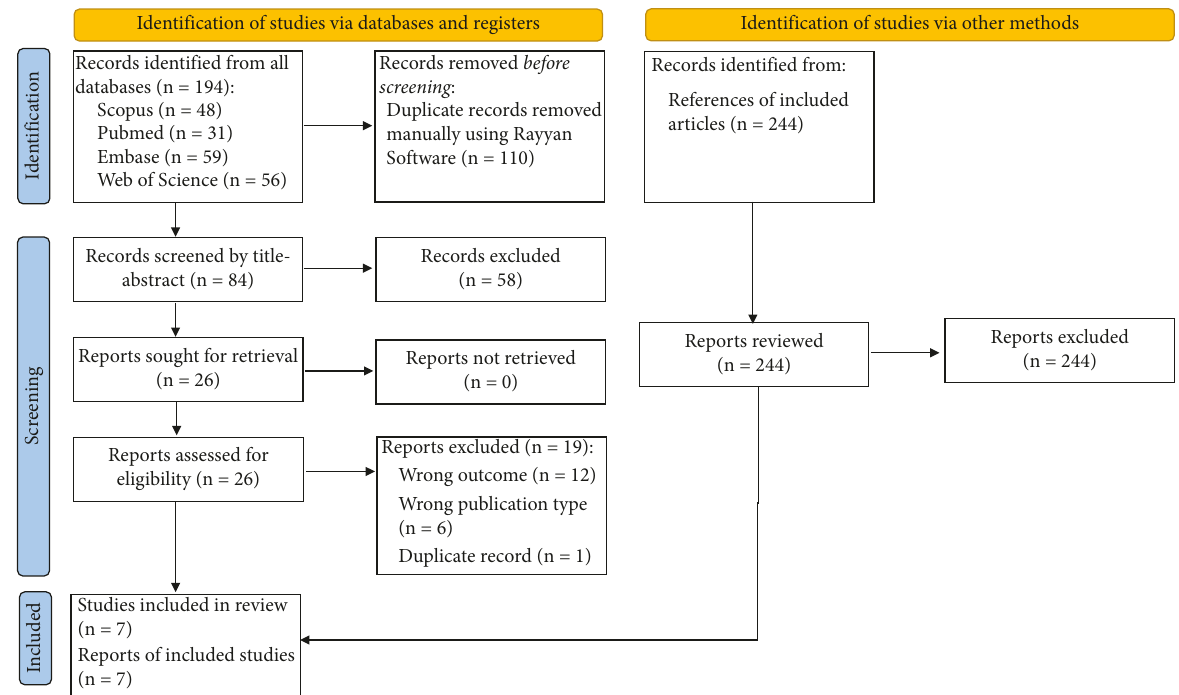
Figure 1: Flow diagram summarizing the process of the literature search and selection. Table 1: Characteristics of included studies assessing the relationship between copeptin and metabolic syndrome ( n � 7). Study